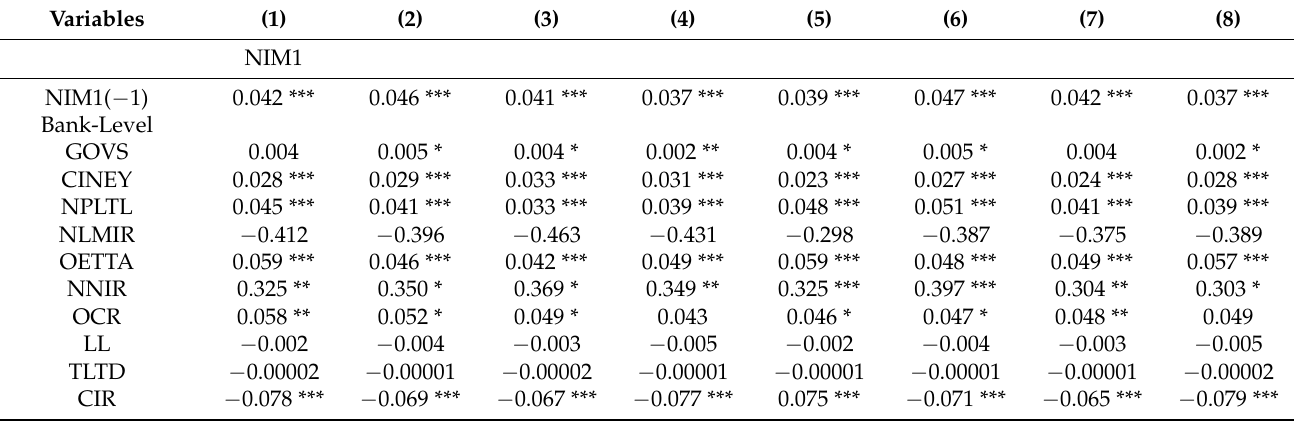
Table 12. Using dynamic panel systems GMM